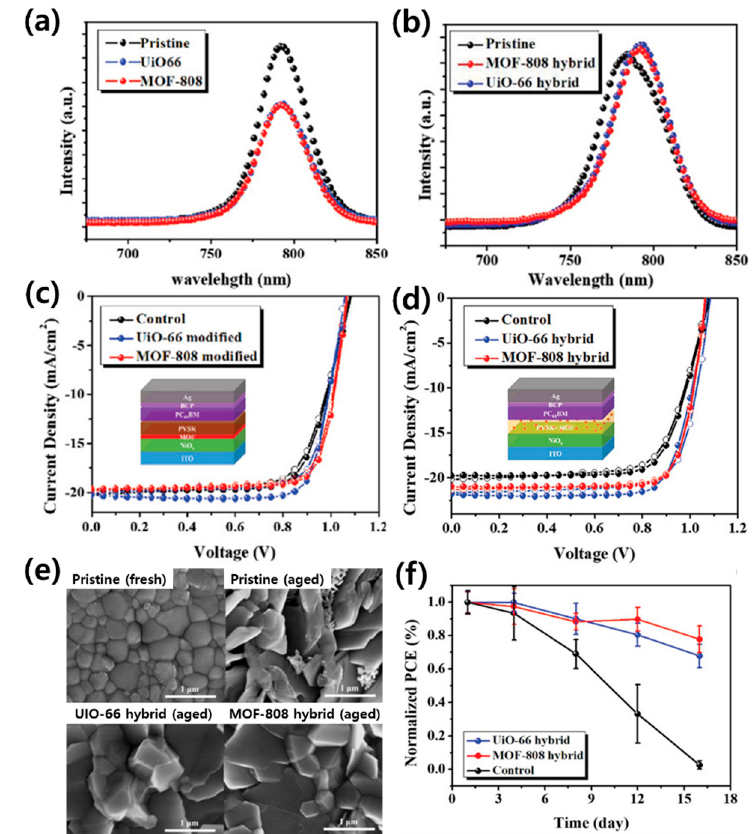
Figure 13. Photoluminescence spectra of ( a ) bilayer MOF / perovskite films, and ( b ) hybrid P-MOF films. The J–V curves of ( c ) the PSC employing MOF as a bilayer and ( d ) the hybrid P-MOF PSC. ( e ) SEM images of the films after 30 days of aging. ( f ) The PCEs of the fabricated devices as a function of storage time in ambient air (25 ◦ C and RH: 60 ± 5%). Reprinted from [183] with permission. Table 2. Summary of the photovoltaic performance of MOF-derived PSCs discussed in the text. MOF